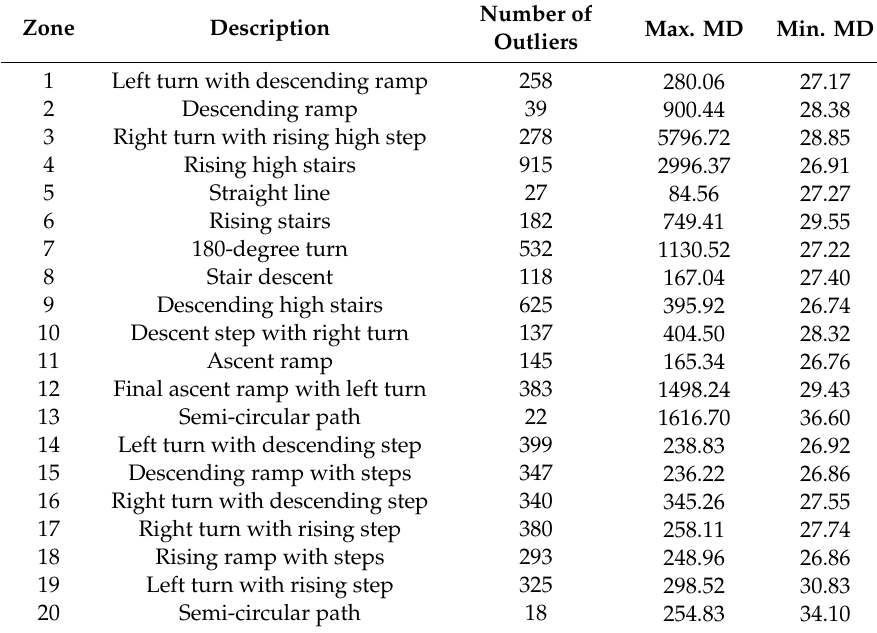
Table 3. Number of multivariate outliers by each di ff erent zone and Mahalanobis distances